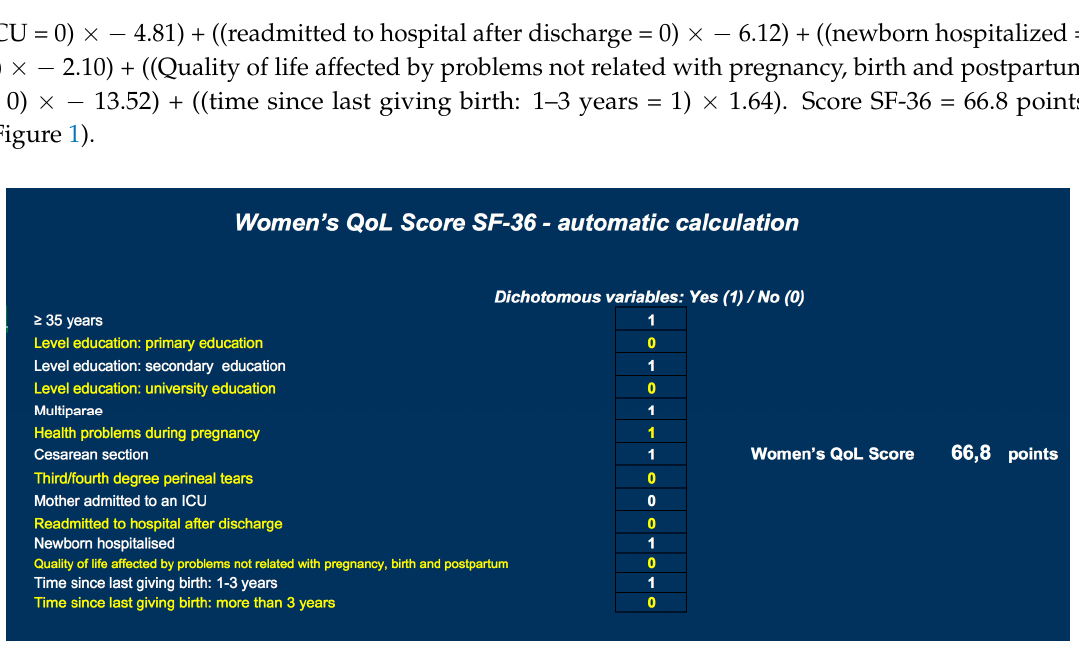
Figure 1. Score obtained in the SF-36 of the example created to explain the operation of the calculator.